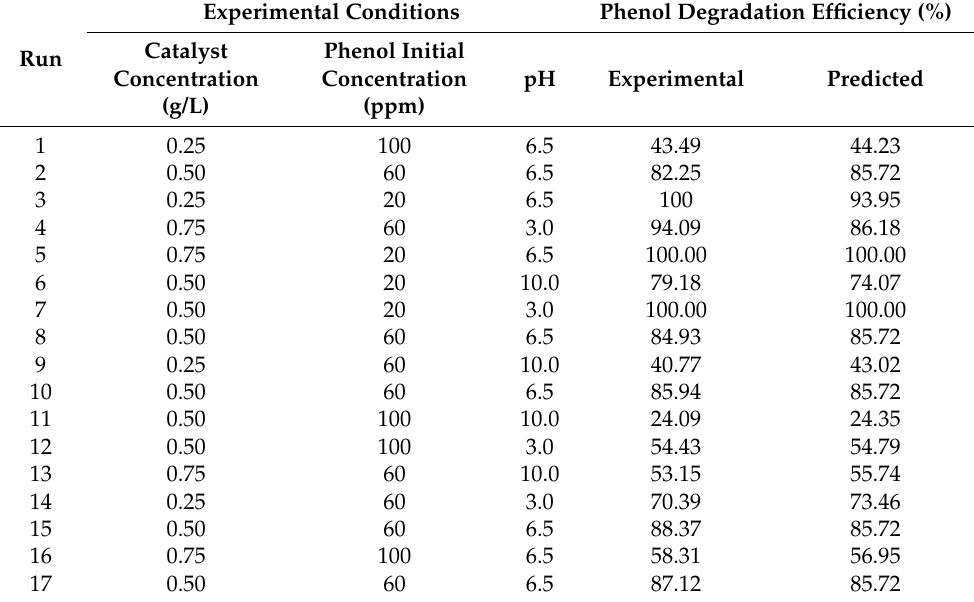
Table 3. Box–Behnken design with experimental and predicted phenol degradation efficiency values with Equation